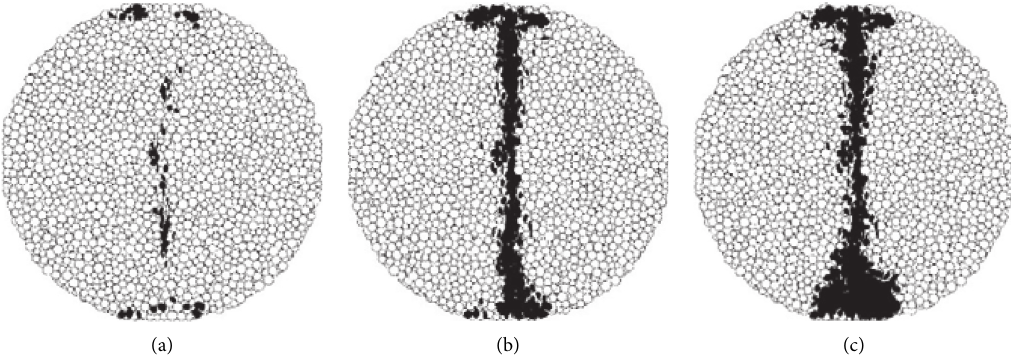
Figure 20: Microcracks distribution in CCNBD specimen (A3). (a) Crack initiation. (b) Crack growth. (c) Sample failure.